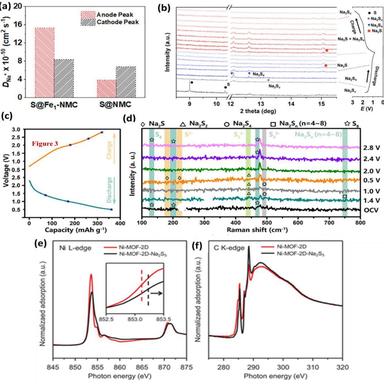
A) Naþ diffusion coefficients of S@Fe1-NMC and S@NMC, and b) in-situ synchrotron XRD results of S@Fe1-NMC cells at various states of charge/discharge. Reprinted (adapted) with permission from Ref.. Copyright 2021 Elsevier. C) schematic illustration, and d) in situ Raman analysis of S@Co/C/rGO electrode in NaeS battery at various states of charge/ discharge. Reprinted (adapted) with permission from Ref.. Copyright 2020 Elsevier. E) Ni L-edge NEXAFS spectra, and F) C K-edge NEXAF